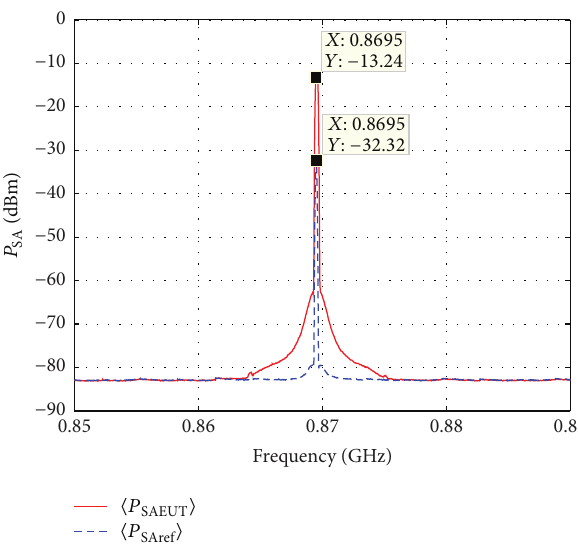
Figure 5: Measured averaged SA readings.